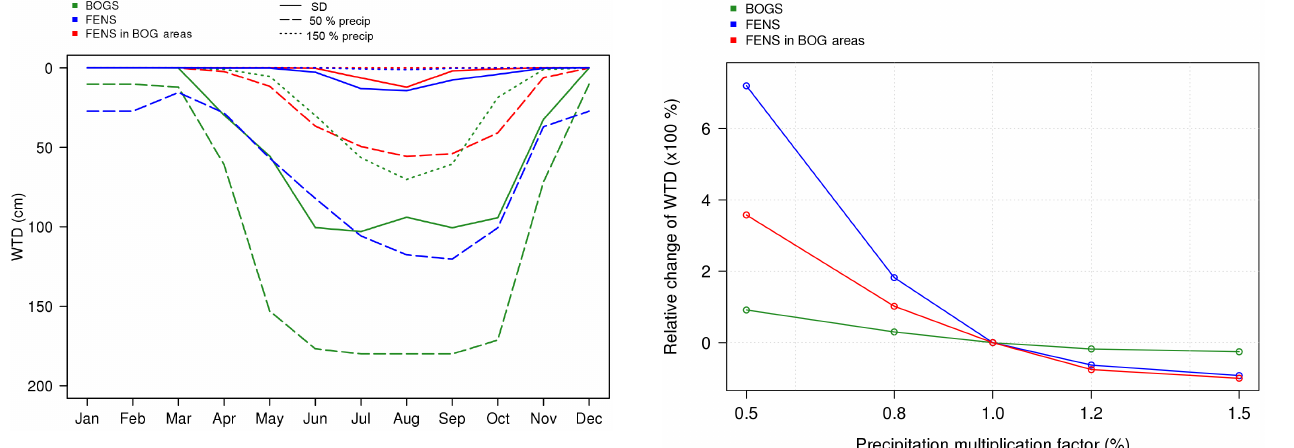
Figure 7. Seasonal cycle of WTD of minerotrophic (FENS), om- brotrophic (BOGS) and minerotrophic in regions localized as om- brotrophic (FENS in BOGS areas) with the standard precipitation (STD, full line), 50% of the precipitation (50% PRECIP, dashed line) and 150% of the precipitation (150% PRECIP, dotted line).